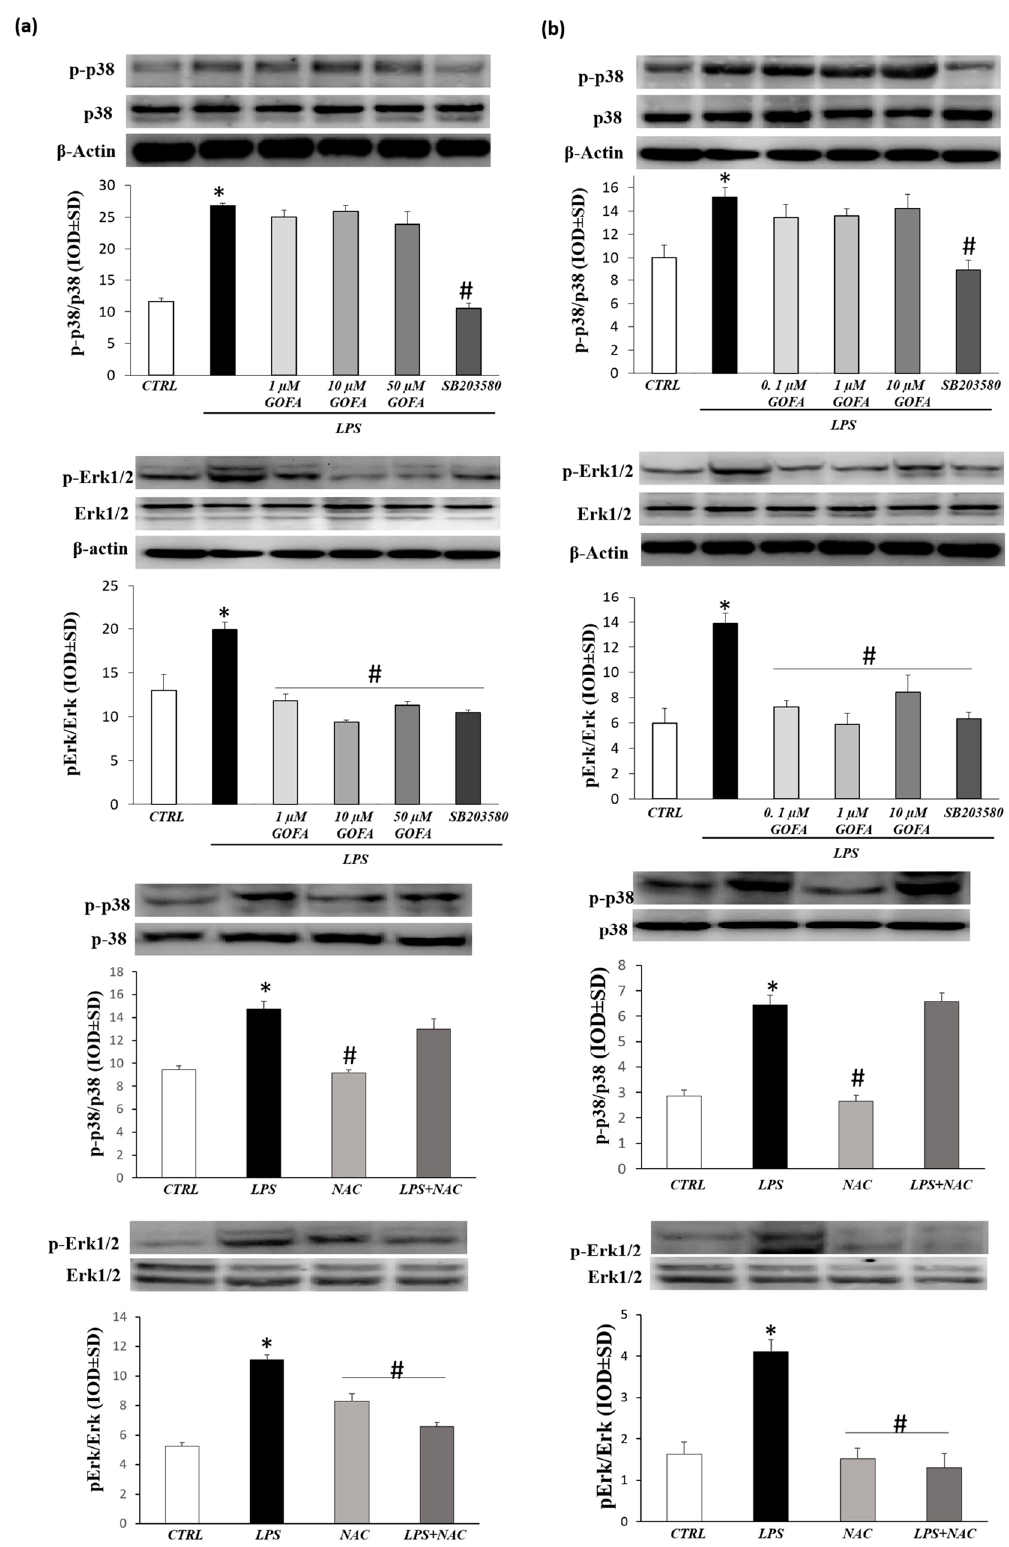
Figure 8. Effects of GOFA on p-p38 and pERK1/2 kinase. Analysis of phosphorylation level of p38 and extracellular signal-regulated kinases (ERK) in GOFA-treated U937 ( a ) and HCT116 ( b ) by Western blotting. Selective inhibitor of p38 (SB203580), ERK (PD980559) and ROS (N-acetyl-L-cysteine, NAC) was used as positive control. Cells were pretreated with selective